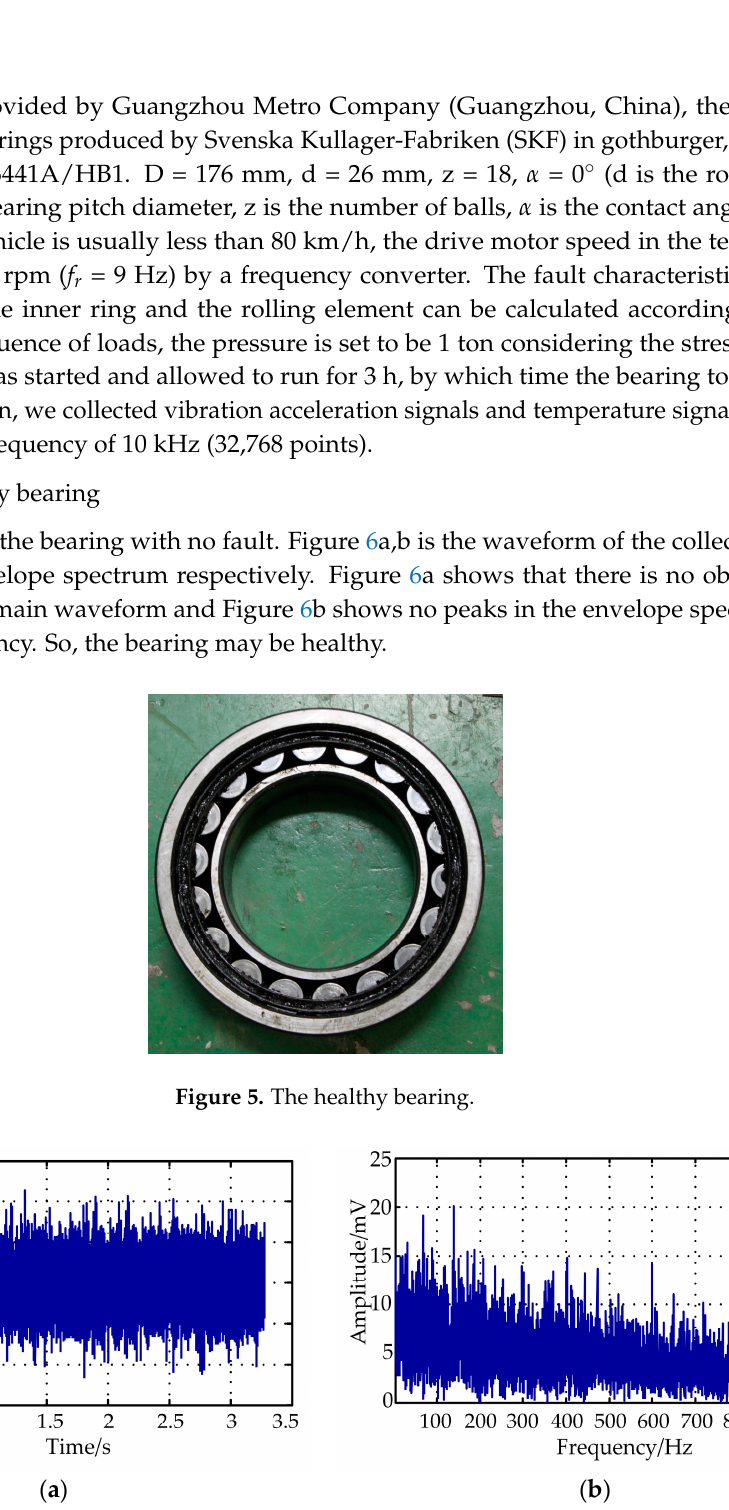
Table 2. The mass functions.